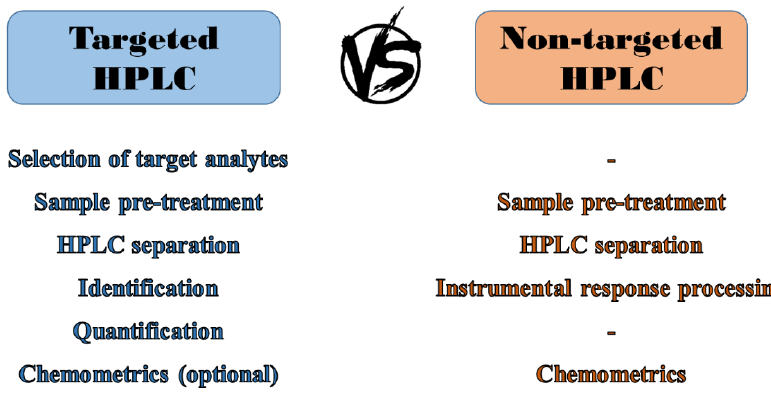
Figure 4. Basic diagram of the process of targeted and non-targeted analysis.